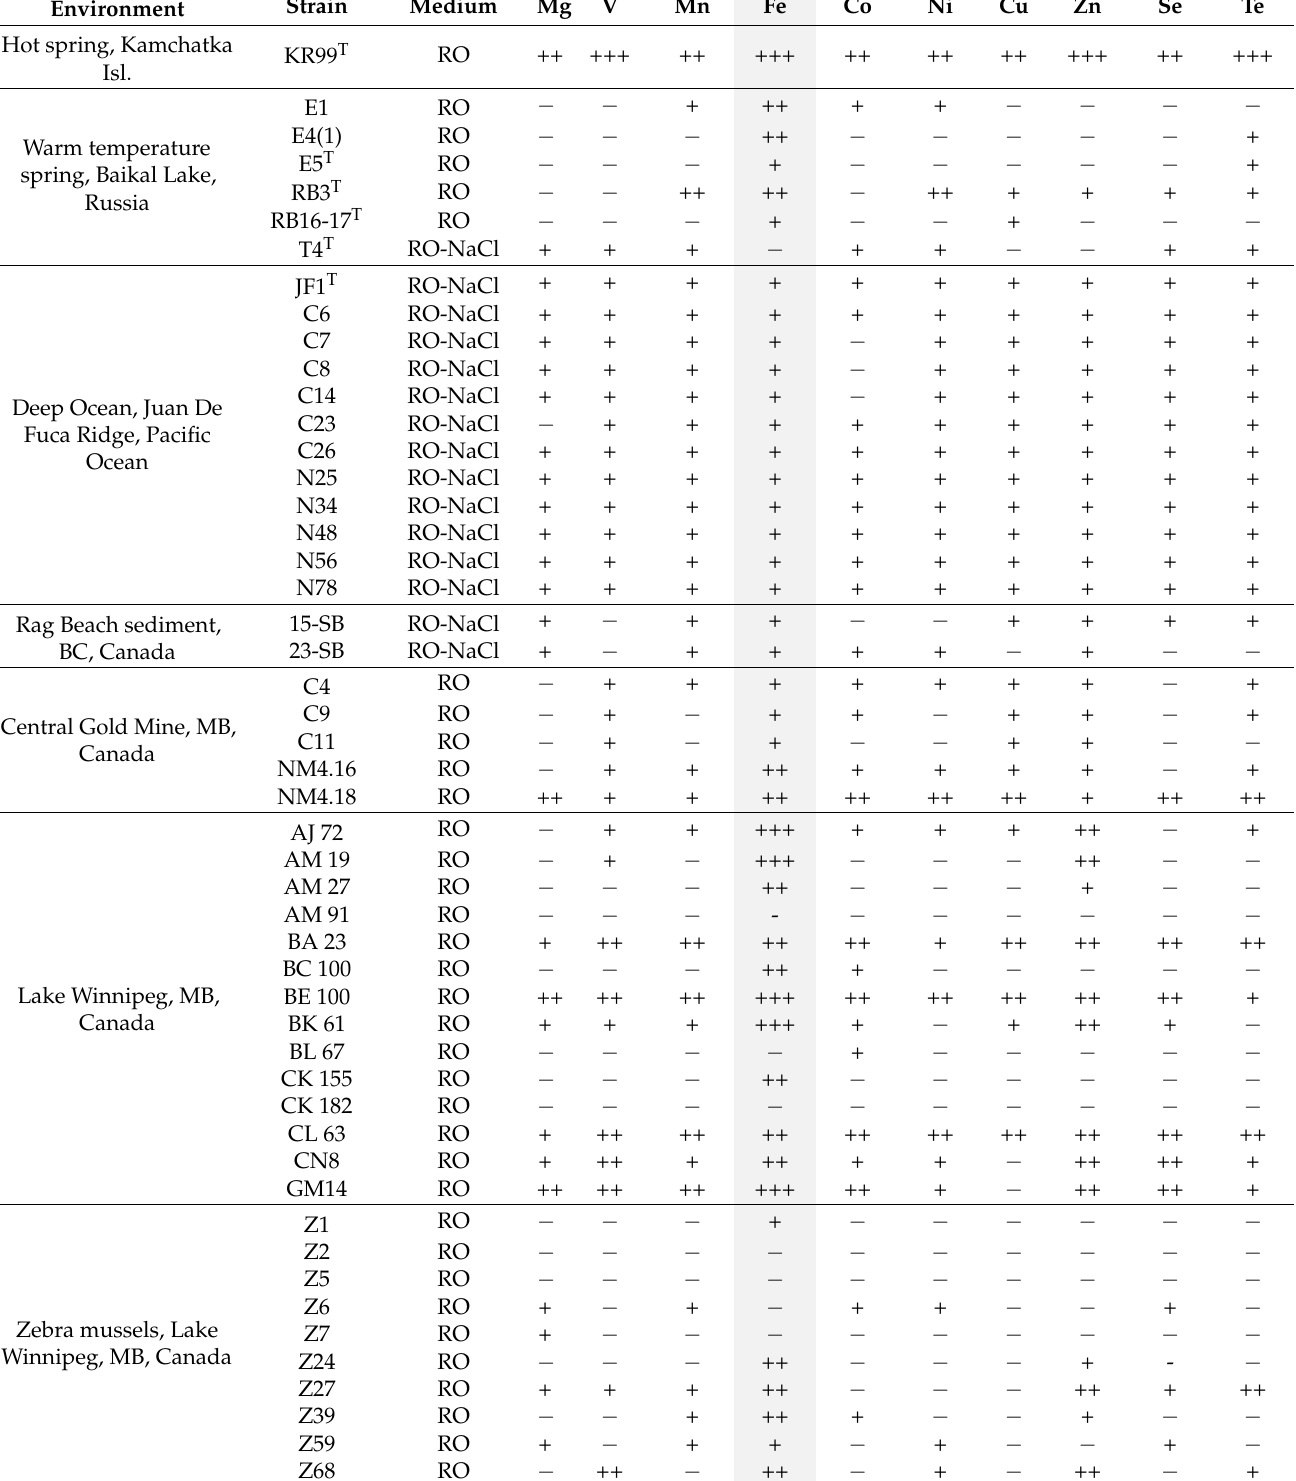
Table 1. Freshwater and saline AAP analyzed for metal(loid)-chelation via CAS assays with varied cations. Environment Strain Medium Hot spring, Kamchatka Isl. Warm temperature spring, Baikal Lake,